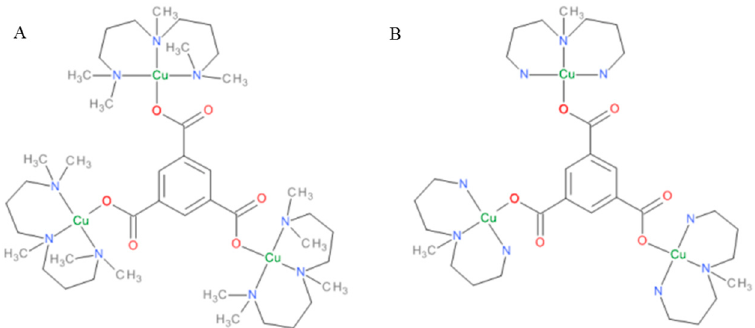
Figure 1. Structural formulas of the complex cations [Cu 3 (pmdien) 3 (btc)] 3+ , where pmdien = N , N , N ′ , N ′′ , N ′′ -pentamethyl-diethylenetriamine, (M2) ( A ) and [Cu 3 (mdpta) 3 (btc)] 3+ , where mdpta = N , N -bis- (3-aminopropyl)methylamine), (M3) ( B ).